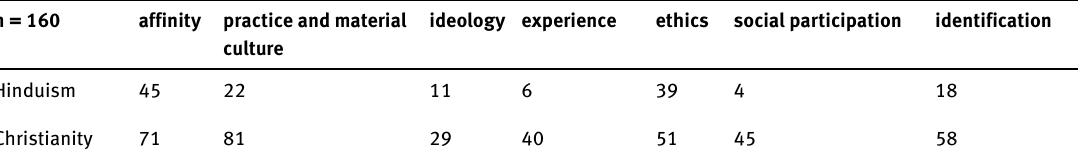
Table 11. Frequency of modalities in the group Christianity – Hinduism n = 160 affinity practice and material ideology experience ethics social participation culture